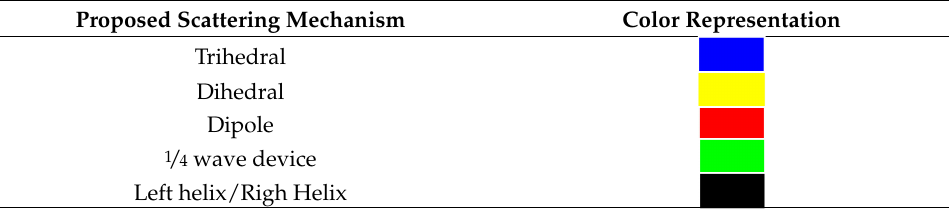
Table 3. Color correspondence to the used in the proposed method elementary